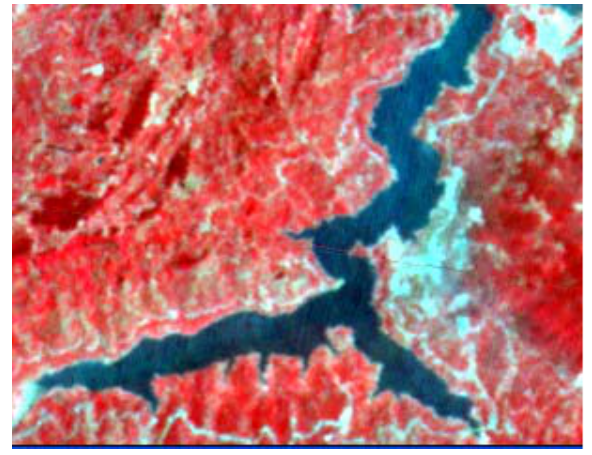
Figure 7. Cbers image composed of 432 spectra in Guojiaba Town.